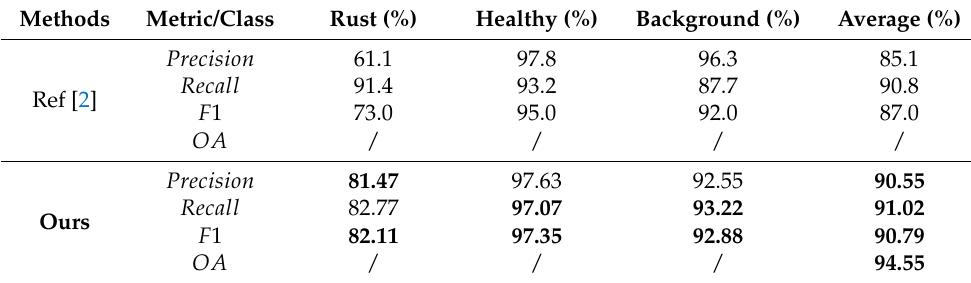
Table 6. Performance with inputs B.